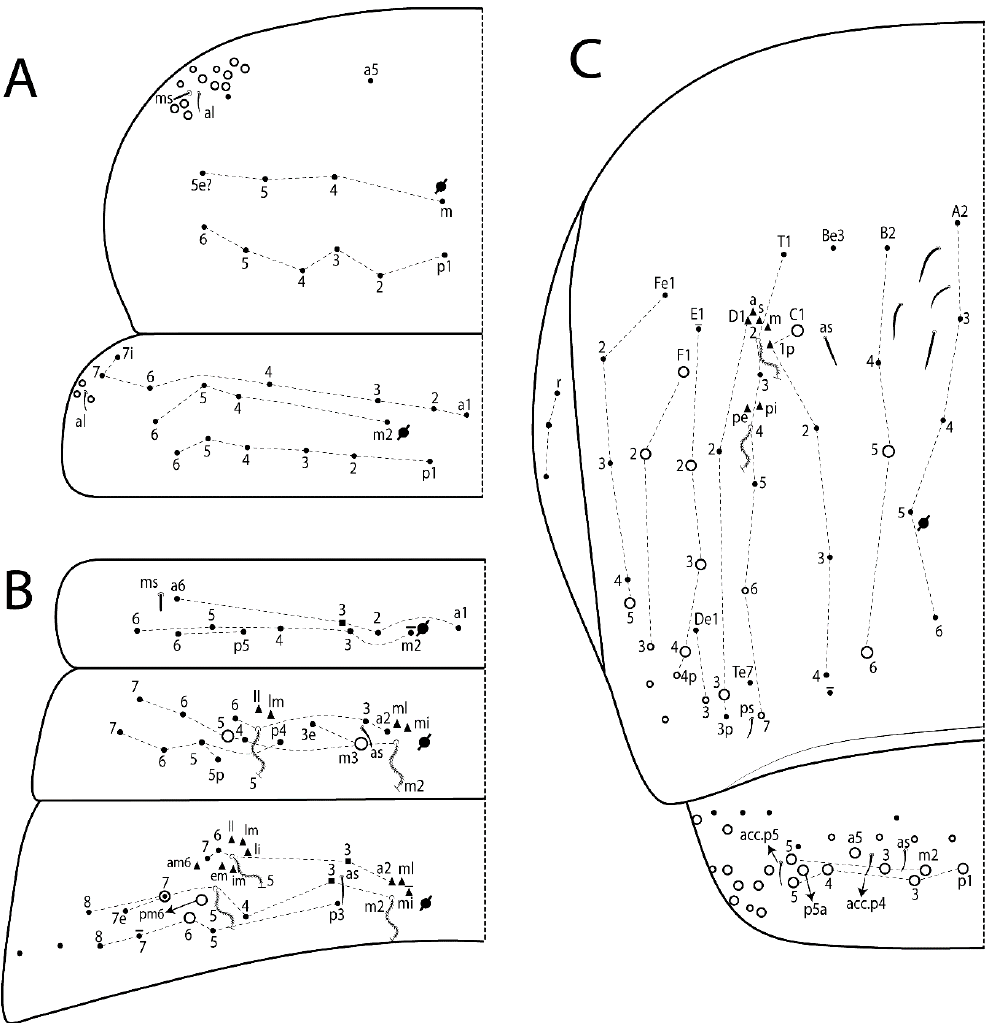
Figure 47. Pseudosinella diamantinensis sp. nov.: dorsal chaetotaxy. ( A ) Th II–III; ( B ) Abd I–III; ( C ) Abd IV–V.